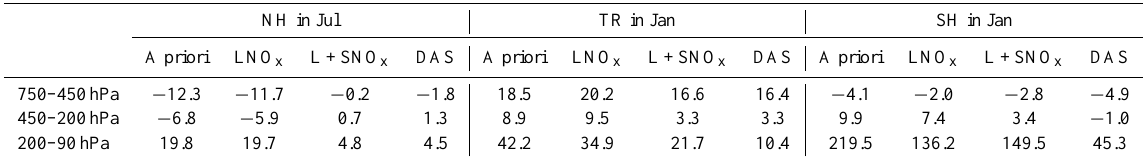
Table 9. The mean ozone concentration bias (in ppbv) between the CHASER simulations and the global ozonesonde observations for January 2007 in the NH (25–90 ◦ N) and for July 2007 in the tropics (TR, 25–25 ◦ N) and the SH (90–25 ◦ S). The CHASER simulation results using the a priori emissions sources (A priori), the LNO x sources (LNO x ), and the LNO x sources and surface NO x emissions (L+SNO x ) are shown. The results from the CHASER-DAS simultaneous assimilation are also listed (DAS). NH in Jul TR in Jan SH in